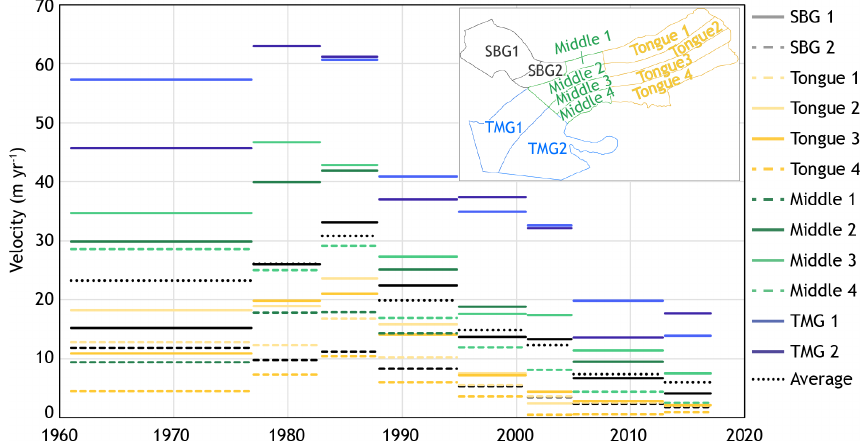
Figure 8. Evolution of surface flow since 1961 for the different sections of the glacier tongue as labelled in the inset map. After an increase in the 1970s and 1980s a rapid slowdown occurred in all observed regions. SBG: Schönbielgletscher; TMG: